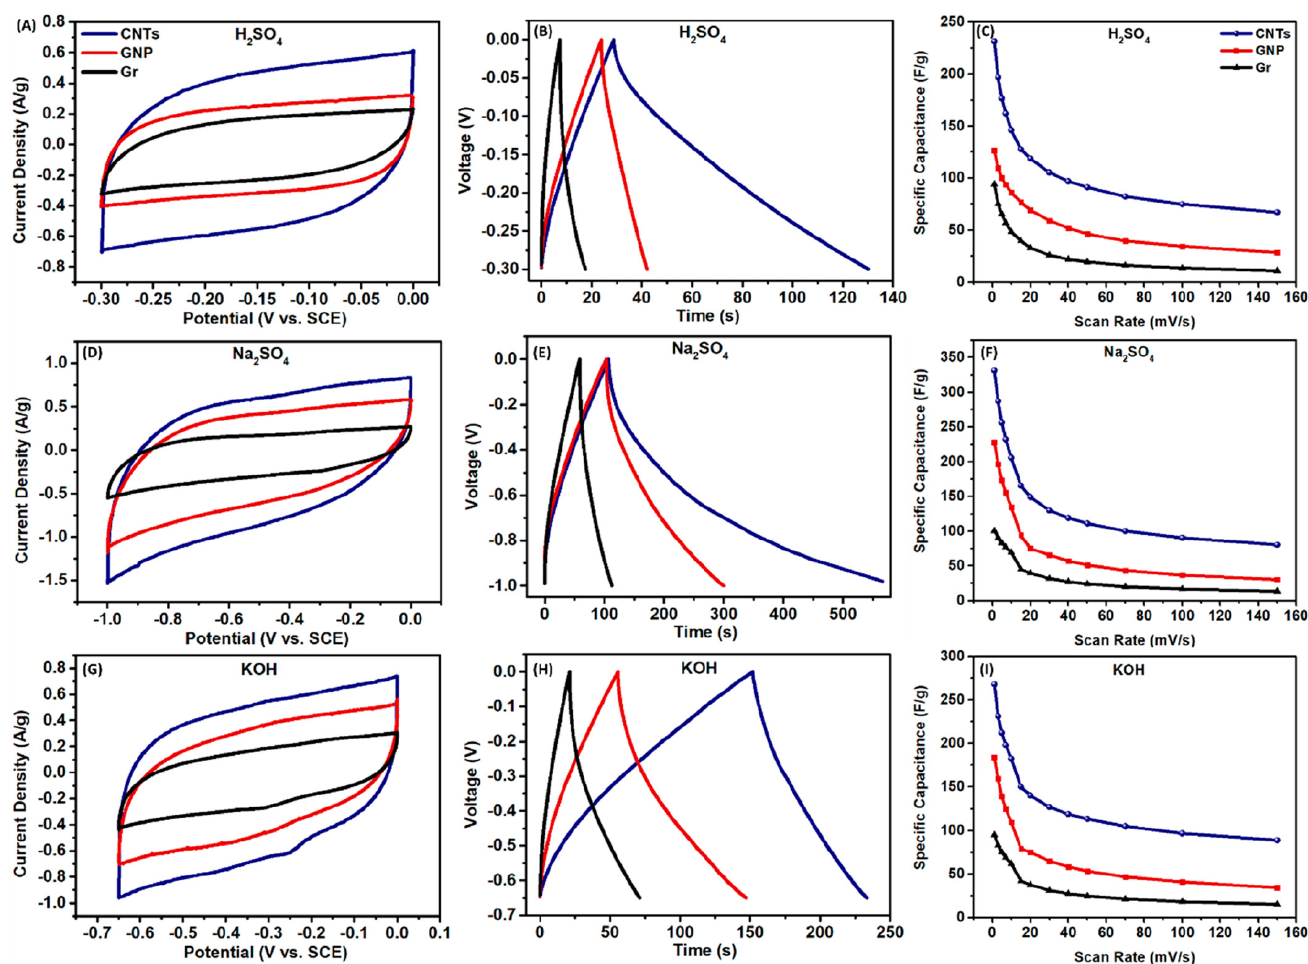
Figure 10. Performance of the carbon materials in the negative potential window in different elec- trolytes measured in three-electrode configuration: (in H 2 SO 4 electrolyte) ( A ) CVS of carbon materials at 5 mV s − 1 , ( B ) GCDs of carbon materials at 0.7 A g − 1 , ( C ) rate capability of the carbon materials; (in Na 2 SO 4 electrolyte) ( D ) CVS of carbon materials at 5 mV s − 1 , ( E ) GCDs of carbon materials at 0.7 A g − 1 , ( F ) rate capability of the carbon materials; (in KOH electrolyte) ( G ) CVS of carbon materials at 5 mV s − 1 , ( H ) GCDs of carbon materials at 0.7 A g − 1 , ( I ) rate capability of the carbon materials. Reprinted with permission from Ref. [21]. 2021,